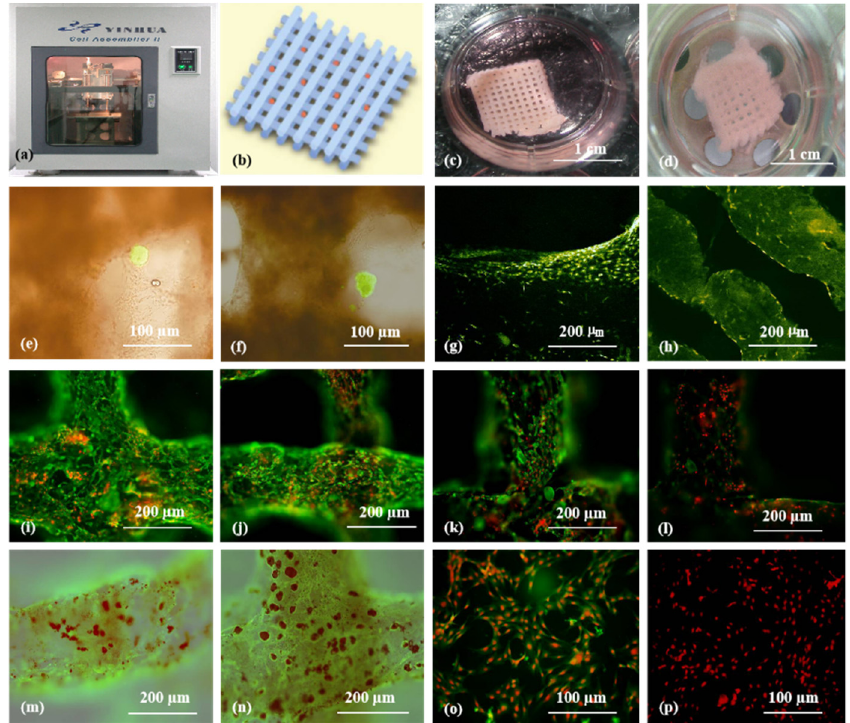
Figure 4. Cell-laden hydrogel constructs printed by Professor Wang: ( a – d ) grid gelatin/alginate/fibrin constructs containing ASCs and islets; ( e , f ) immunofluorescence staining of islet cells in the constructs; ( g , h ) immunofluorescence staining of ASCs differentiated into endothelial cells with EGF; ( i – l ) endothelial cell (green) immunostaining, nuclear (red) propidium iodide (PI) staining; ( m , n ) immunostained endothelial cells (green), and adipocytes (red) stained with oil red O; ( o , p ) immunostaining of two-dimensional (2D) cultured endothelial cells (green), differentiated from ASCs with pyridine iodide staining nucleus (red). Reprinted from Ref. [75].